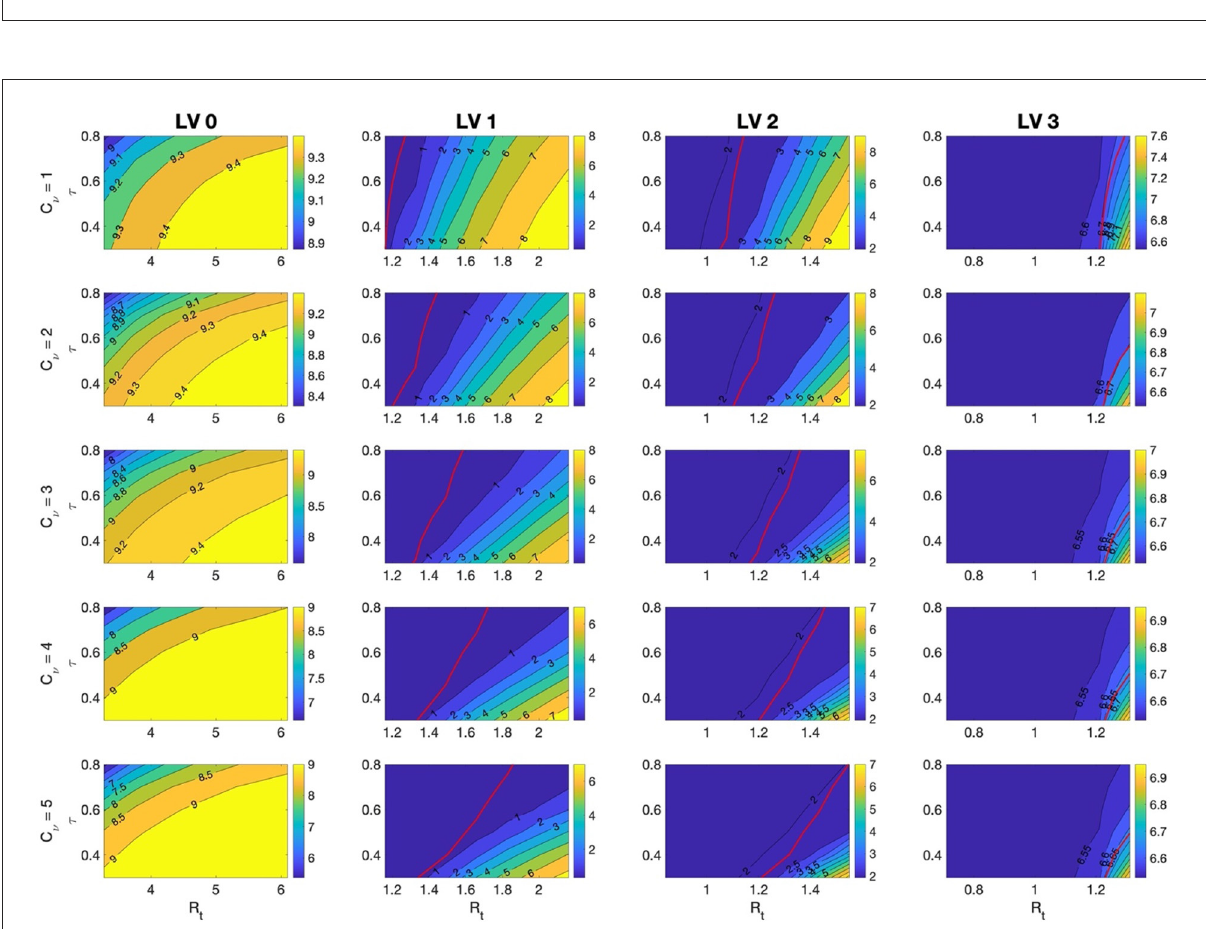
FIGURE6 The ratio of total costs to GDP for τ = 0.3 − 0.8 and for R t corresponding to β that is varied as β × C β for C β = 0.7 − 1.3 under SD LV 0, 1, 2, and 3, and the rollout speed C ν = 1, 2, 3, 4, 5. Red lines indicate the case when the maximum number of hospitalized patients with severe symptoms is the capacity of the intensive care unit, 2,800, for COVID-19 patients in Korea. It means that the maximum number hospitalized patients with severe symptoms is lower than capacity on the left side of the red